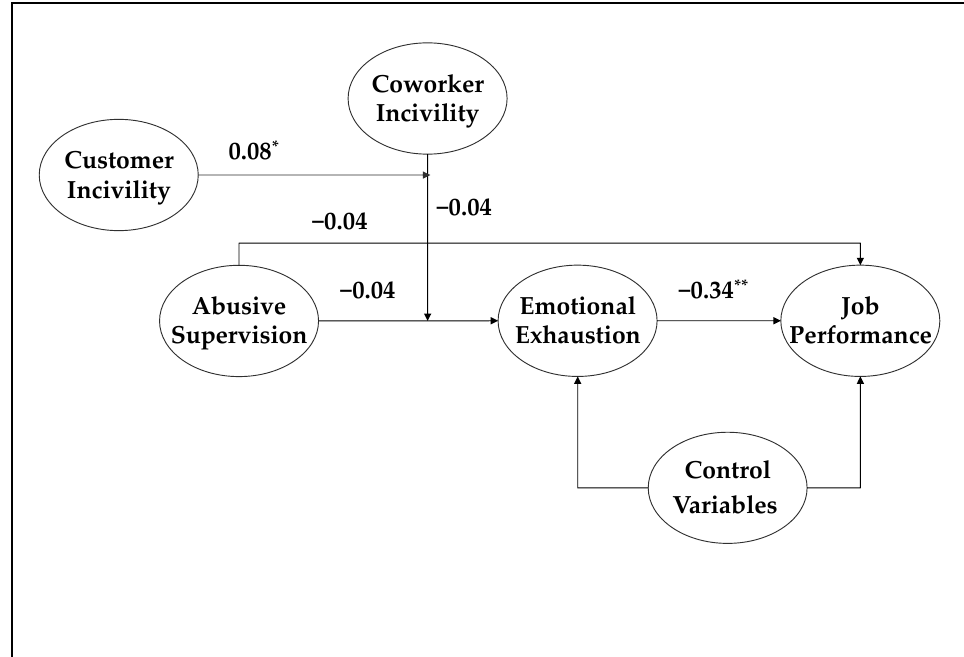
Figure 3. Three-way interaction effect of abusive supervision, coworker incivility, and customer incivility on emotional exhaustion. * p < 0.05 , ** p < 0.01. b = unstandardized coefficient.